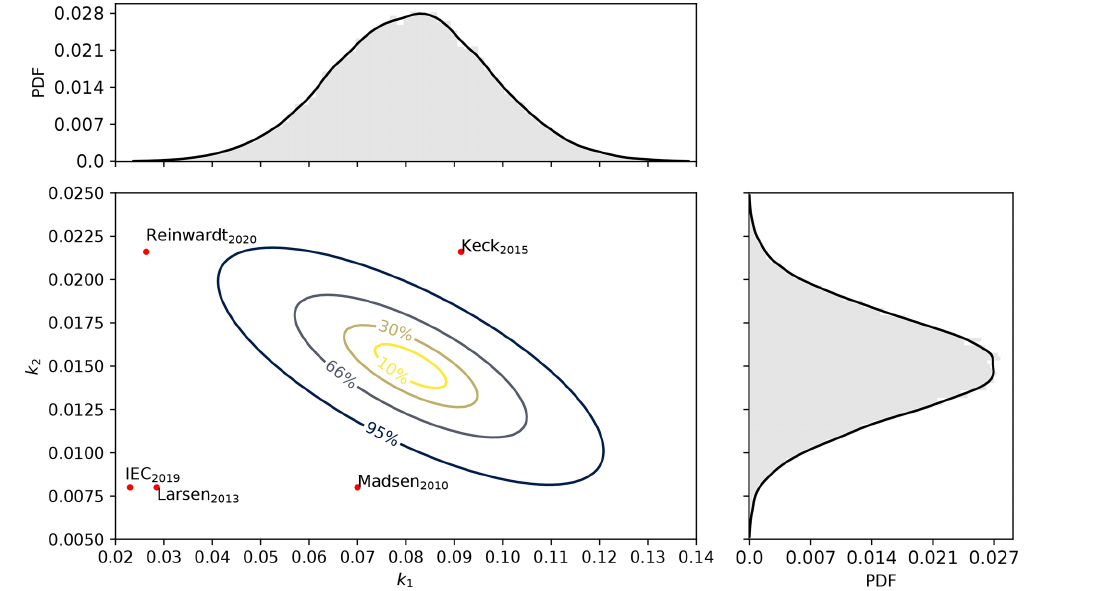
Figure 7. Joint and marginal posterior PDFs of k 1 and k 2 parameters. The uncertainty regions representing the 10%, 30%, 66%, and 95% confidence intervals are shown. The histograms obtained from 40000 MCMC samples and the corresponding empirical PDFs are also included. The calibration parameters from early studies are shown with red markers and discussed in the